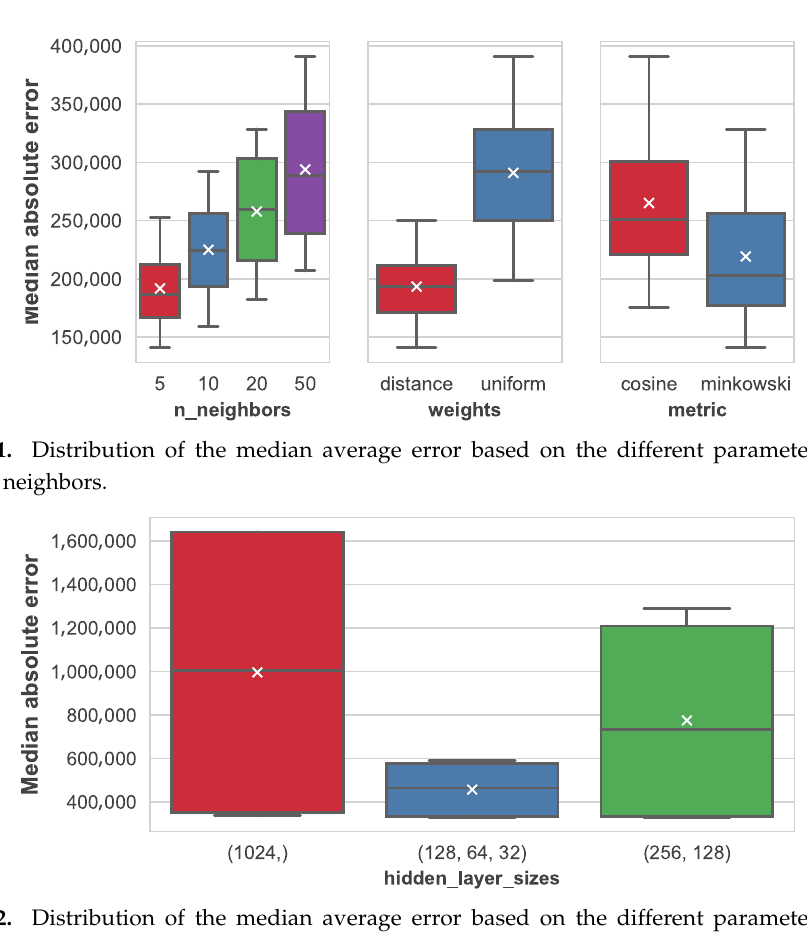
Figure 12. Distribution of the median average error based on the different parameters for the multi-layer